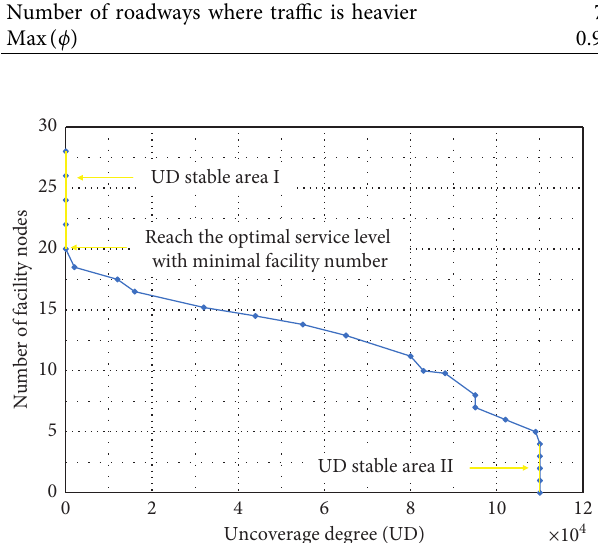
Figure 6: The UD variation by facility location numbers.